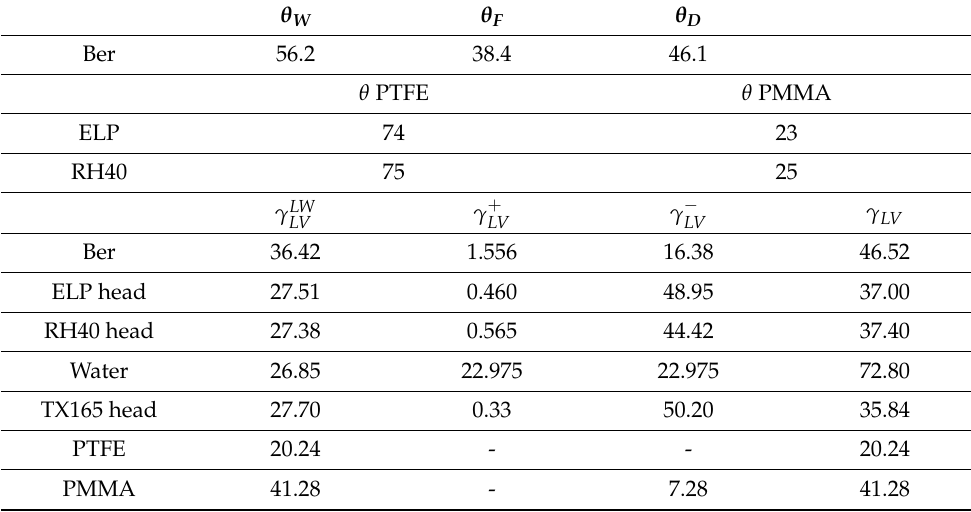
Table 1. The values of the contact angles of water ( θ W ) , formamide ( θ F ) , and diidomethane ( θ D ) on the pressed Ber; the contact angles ( θ ) of ELP and RH40 on PTFE and PMMA surfaces; and the components and parameters of the surface tension of water, Ber, ELP, ELP/RH40/TX165 head, PTFE and